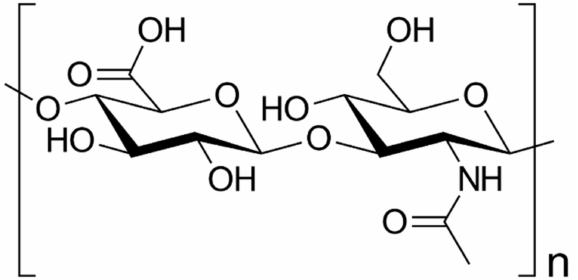
Figure 3. Hyaluronic acid chemical structure. HA structure consists on an anionic glycosaminoglycan non-sulfated repeating disaccharides of β 4-glucuronic acid (GlcUA)- β 3-N-acetylglucosamine